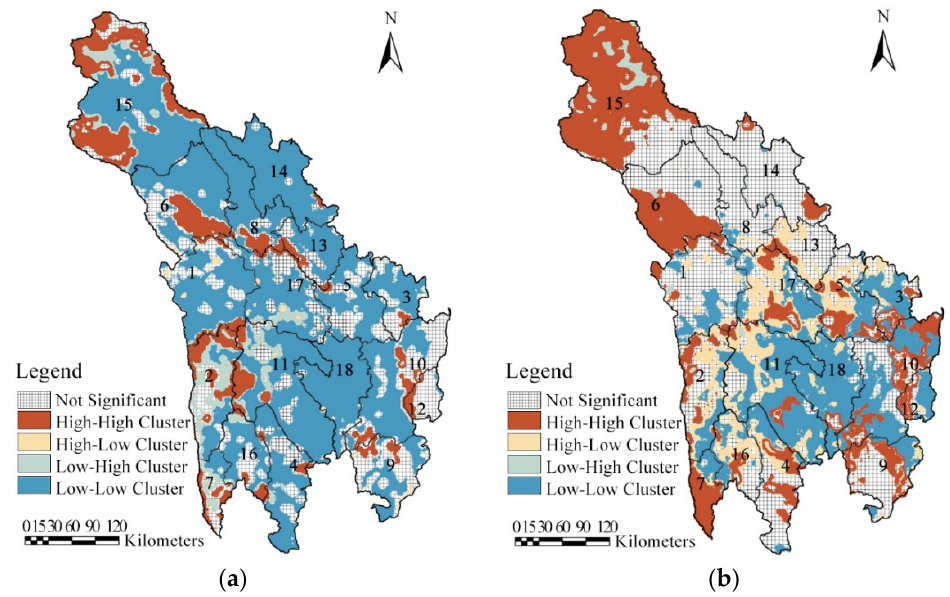
Figure 5. ( a ). LISA cluster graph of local spatial autocorrelation on LVI. ( b ). LISA cluster graph of local spatial autocorrelation on LHAI.